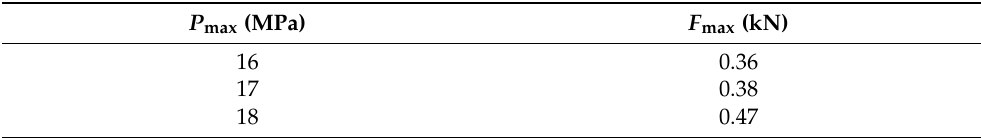
Table 4. Average value of F max of tensile test samples at P max of 16, 17, and 18 MPa.